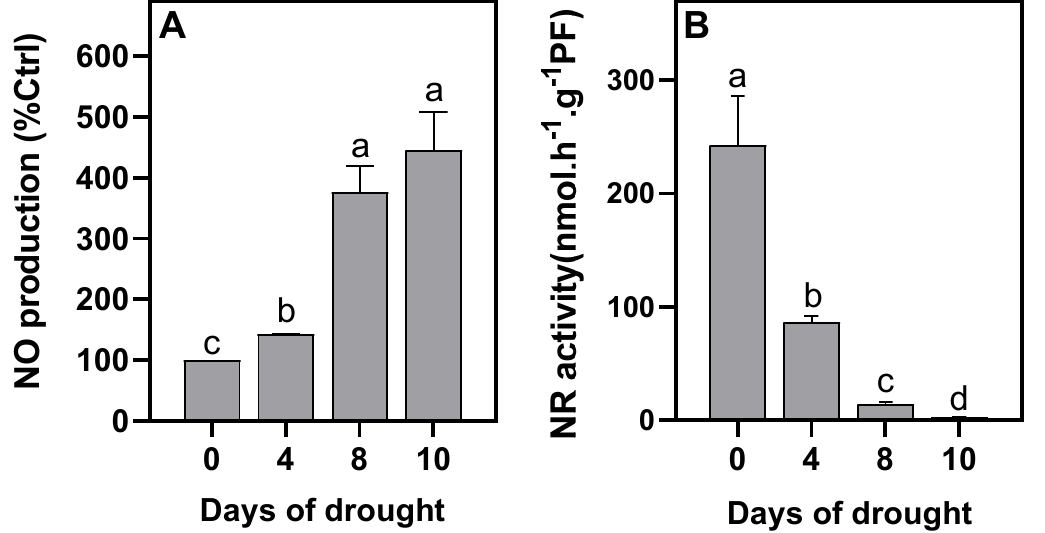
Figure 4. Effects of water deprivation on Vicia faba nodule NO production ( A ) and nitrate reductase activity ( B ). Data are means ± SD of three biological replicates. Letters above the bars represent sig- nificant differences according to one-way ANOVA at p < 0.05. NO, nitric oxide; NR, nitrate reductase. Taken together, the increased expression of the VfAlaAT , VfADH , VfPgb1.1 ,